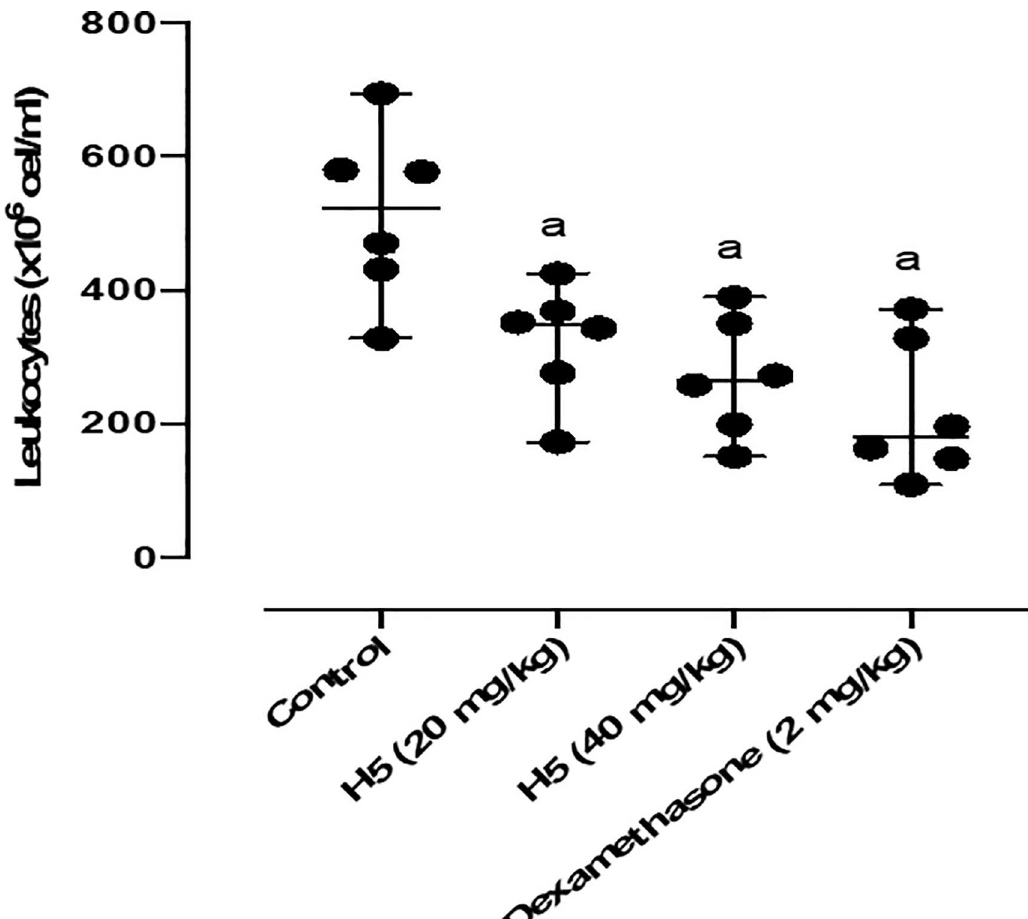
Fig 11. Effect of H5 (20 and 40 mg/kg, p.o.) and dexamethasone (2 mg/kg, i.p.) on leukocyte migration into the peritoneal cavity induced by carrageenan in mice. Values are expressed as the mean ± S.E.M. (n = 6, per group), where a indicates p < 0.05, significantly different from the control group, according to ANOVA, followed by Tukey’s